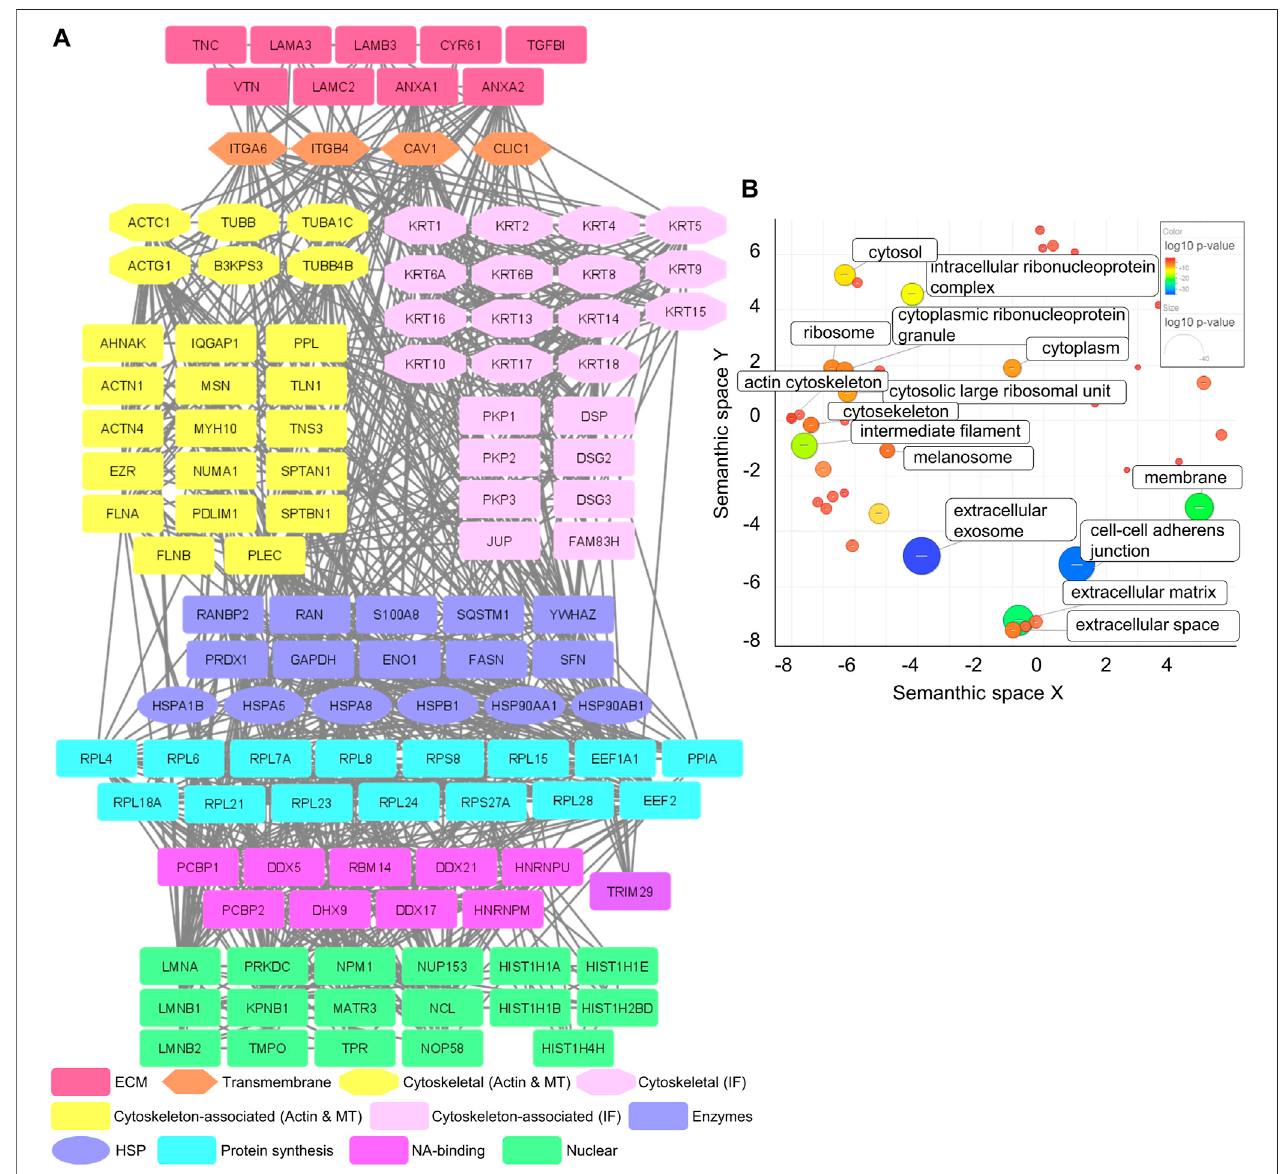
FIGURE 1 | Mass spectrometry analysis of IACs isolated from Cal27 cells. (A) Protein – protein interaction network of proteins identi fi ed in IACs isolated from Cal27 cells. Shapes represent proteins identi fi ed via MS and are labelled with gene symbols and manually grouped and assigned color according to their functional group, as indicatedontheleft.Onlyproteinsidenti fi edwithaminimalnumberoffourspectralcountsinatleastthreeoutof fi veanalyzedbiologicalreplicates,FDR < 5%,probability for protein identi fi cation ≥ 99.9% were visualized. The network was generated with Cytoscape 3.7.2. (B) IACs isolated from Cal27 were enriched with proteins connected to the membrane, cytoskeleton and ECM components. Proteins from (A) were assigned to functional groups using the DAVID GO database (GOTERM_CC_DIRECT)andvisualizedusingtheREViGOtool,where p -valuesrelatedtoGOtermsofcellularcomponentswererepresentedbythecolorbarandsizeof the circle. Statistically signi fi cant GO terms ( p > 0.05) are presented.